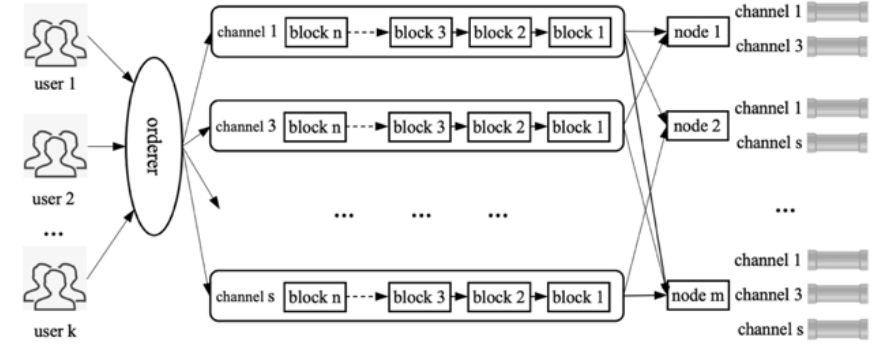
Figure 3. Hyperledger Fabric multi-channel technology.